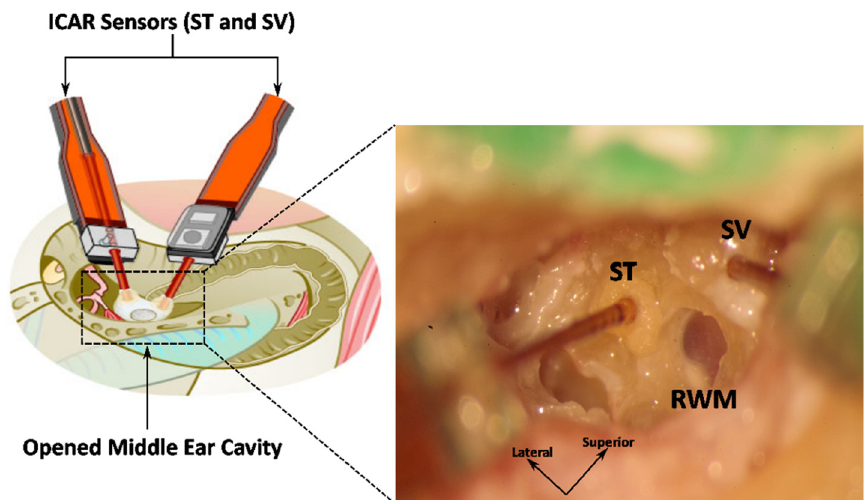
Figure 2. Schematic drawing of the RWM and the ICARs inserted into ST and SV ( left ) and a zoomed microscope image of the basal region of the cochlea ( right ). The spaces between the ICAR sound receptor tube and the bone were first sealed with a thin layer of soft tissue and then reinforced with Jeltrate.